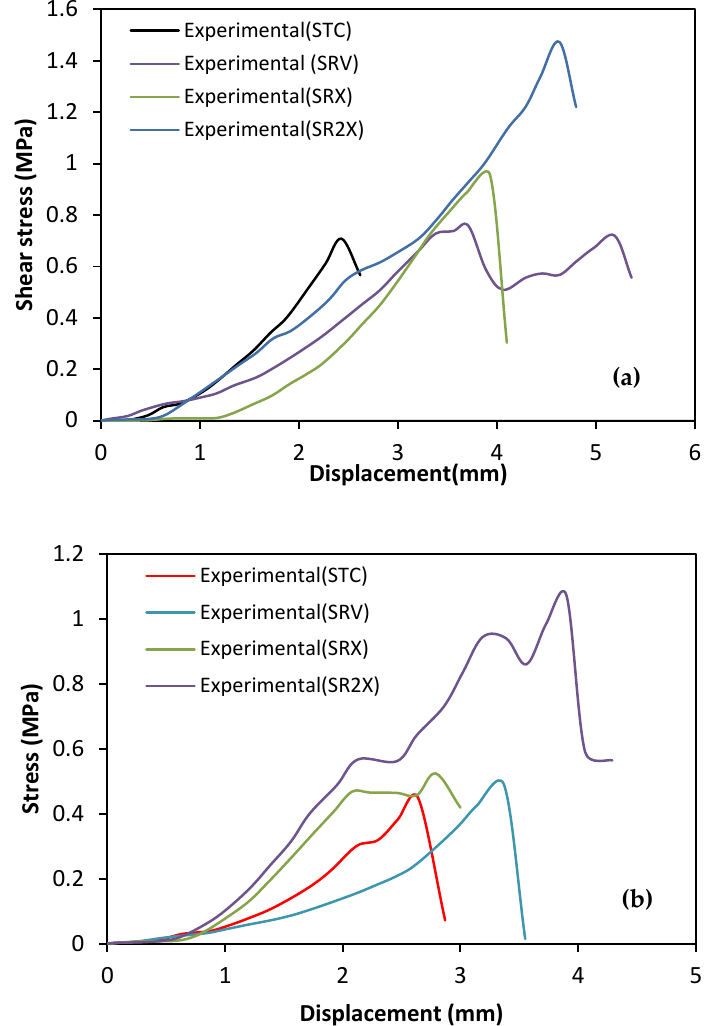
Figure 8. Stress–strain curve for unreinforced and reinforced masonry triplets with different disposi- tion of CFRP strips: ( a ) masonry triplets constructed with mortar A; ( b ) masonry triplets constructed with mortar B.